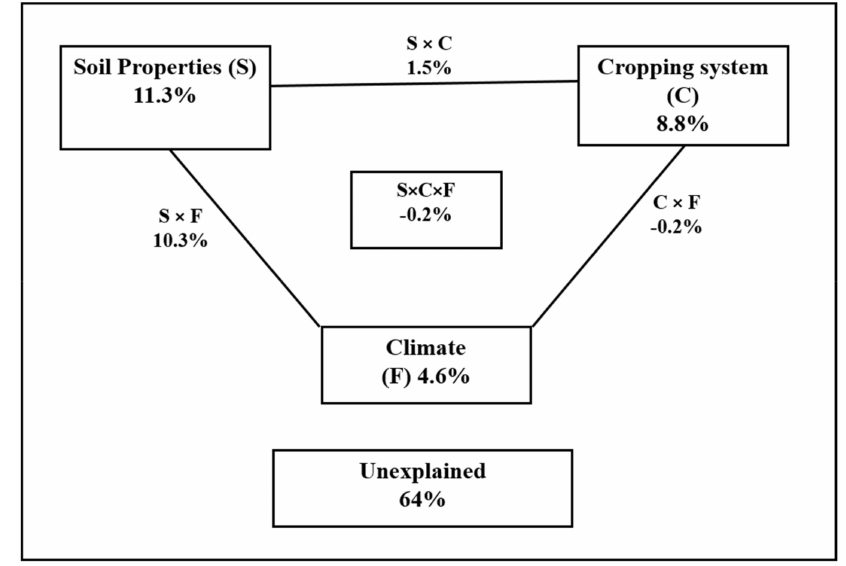
Figure 6. Variance partitioning analysis (VPA) indicating the e ff ects of soil properties, cropping systems, and climatic factors on annual crop yield under long-term green manure rotations in rice-based cropping systems.